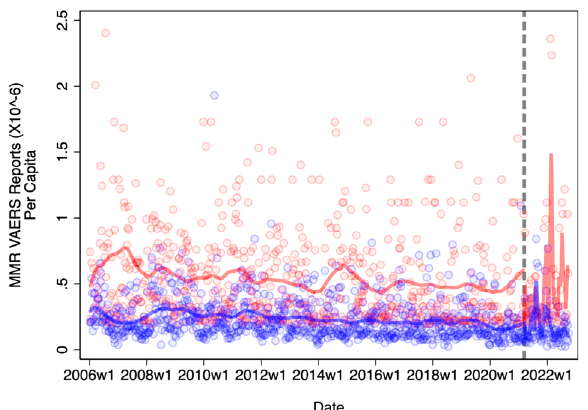
Fig. 1 Weekly Per Capita MMR and MMRV Adverse Event Reports Averaged Across Democratic-Leaning and Republican-Leaning States (1/06 - 10/22). Please see the Online Supplement for detailed information about the measures and analytical procedures used to construct this fi gure, and its corresponding signi fi cance tests. Blue and Red dots correspond to weekly adverse event reports logged across Democratic-leaning and Republican-leaning states (respec- tively); operationalized as the eight states with the strongest records of voting for Republican and Democratic candidates in 2022 (NB: sixteen total states are included in this analysis). Blue and red lines are locally weighted regression lines (bandwidth = 0.10) calculated between each of these points. Weekly VAERS reports are averaged across states, and scaled to account for differences in state-level population. For ease of visual interpretation, those quantities are multiplied by a factor of 10 6 . The dashed gray line indicates the start of March 2021; i.e., an estimate of the general timeframe in which COVID-19 vaccines started to become widely available for American adults beyond those belonging to high-risk populations. Four formal regression discontinuity analyses are available in the online supplement, and suggest that reporting differences between blue and red states were signi fi cantly larger in the post-vaccine availability period ( p > 0.10 two-tailed in just one out of four tests). Outlying observations are trimmed from visual display at 2.5, but are included in the calculation of locally weighted regression lines and regression discontinuity